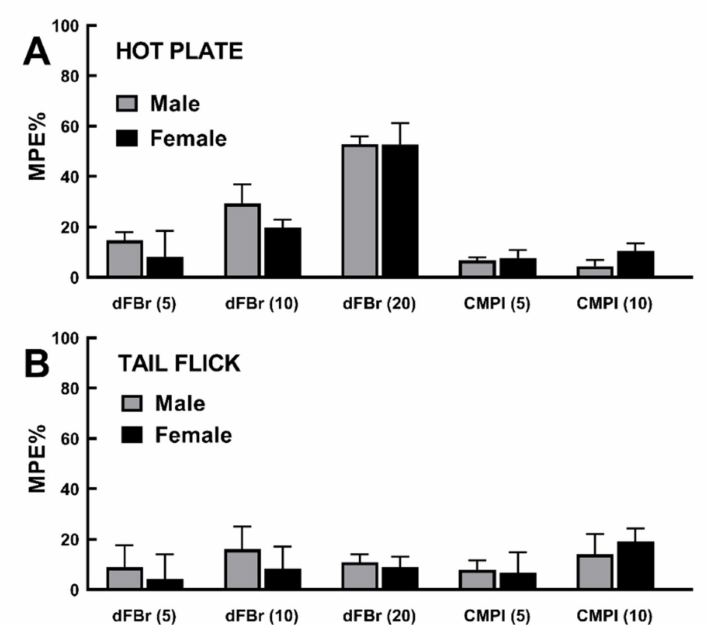
Figure 5. ( A ) E ff ect of rat sex on latency (%MPE + SD) to acute thermal nociception in the Hot Plate test (experiments in Figure 1), recorded 30 min following i.p. injection of dFBr or CMPI (dose indicated in mg / kg rat weight). ( B ) E ff ect of rat sex on latency (%MPE + SD) to acute thermal nociception in the Tail Flick test (experiments in Figure 2) recorded 30 min following i.p. injection of dFBr or